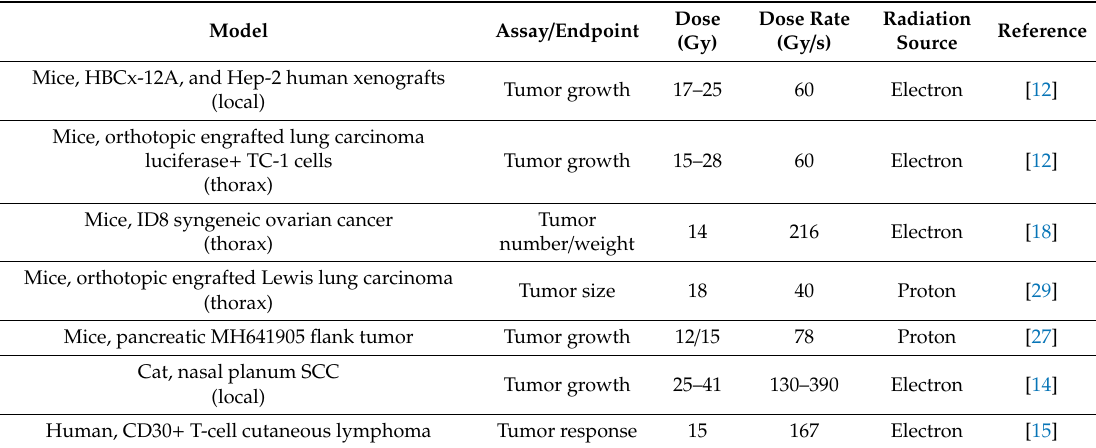
Table 2. Evidence of tumor control from FLASH